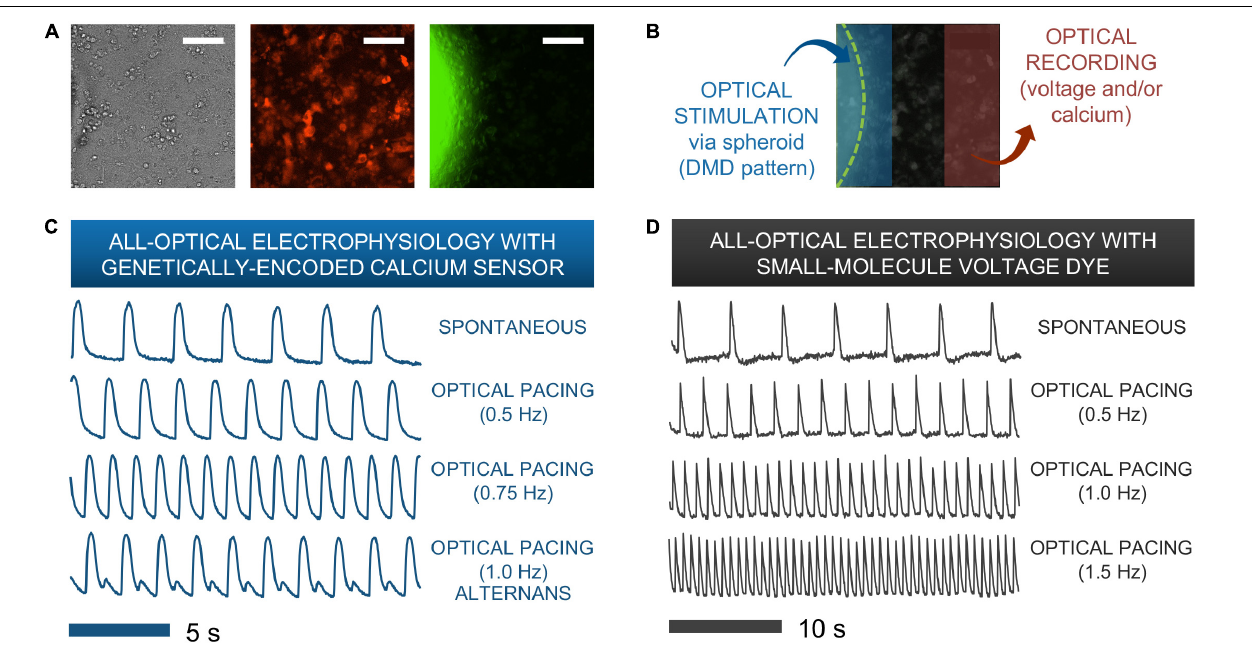
FIGURE 5 | Functional responses from human iPSC-CMs upon spark-cell cluster pacing obtained by all-optical electrophysiology. (A) A typical field-of-view for microscopic optical stimulation experiments featuring brightfield and corresponding fluorescence images. The middle image was produced using a mCherry filter and demonstrates expression of optogenetic sensor for calcium (R-GECO) in the iPSC-CM monolayer. The rightmost image was produced with a YFP filter and shows a portion of the ChR2-eYFP spheroid. Scale bar is 0.1 mm. (B) For recordings, the field-of-view was separated into two non-overlapping areas – patterned optical stimulation including the spheroid and optical recording including only iPSC-CMs labeled with voltage or calcium indicators. (C) Calcium transients from R-GECO-expressing iPSC-CMs showing spontaneous activity and optical pacing ( via the spheroid) at three different frequencies after 7 h of spheroid introduction. While a 1:1 stimulation-to-response is observed for optical pacing at 0.5 and 0.75 Hz, overdrive pacing at 1.0 Hz results in failure of iPS-CMs to fully restore calcium stores between stimulation events, hence calcium alternans are seen. (D) Optical pacing can also be confirmed via spectrally compatible small-molecule voltage dye. This sample shows a 1:1 relationship between stimulation and response for pacing frequencies up to 1.5 Hz after 12 h of spheroid